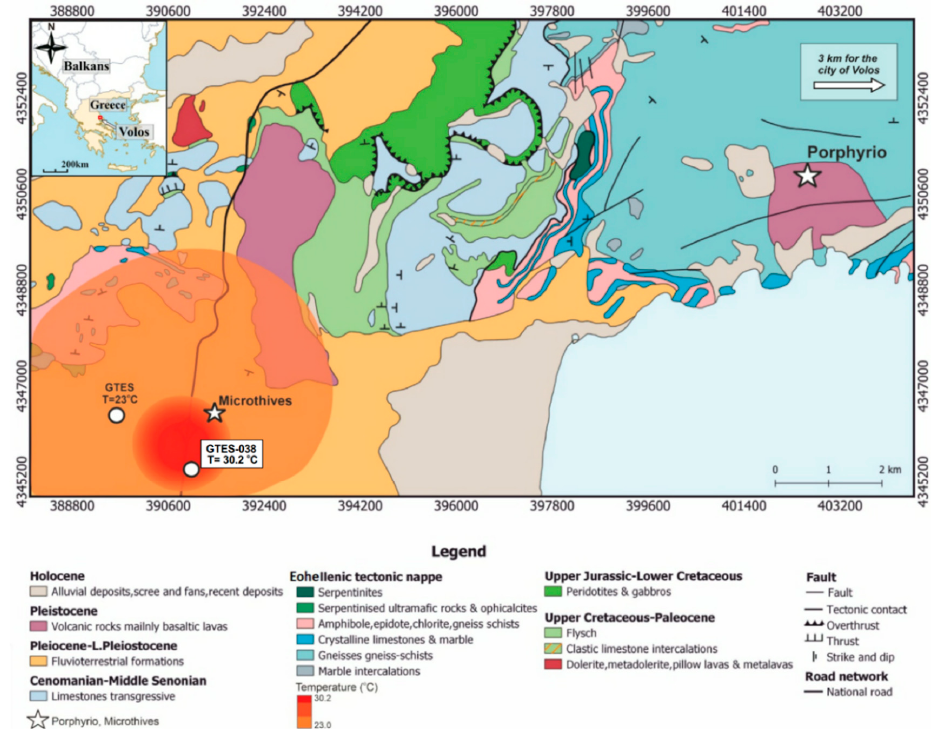
Figure 1. Geological map of Microthives locality and calculated water temperatures, EGSA87.